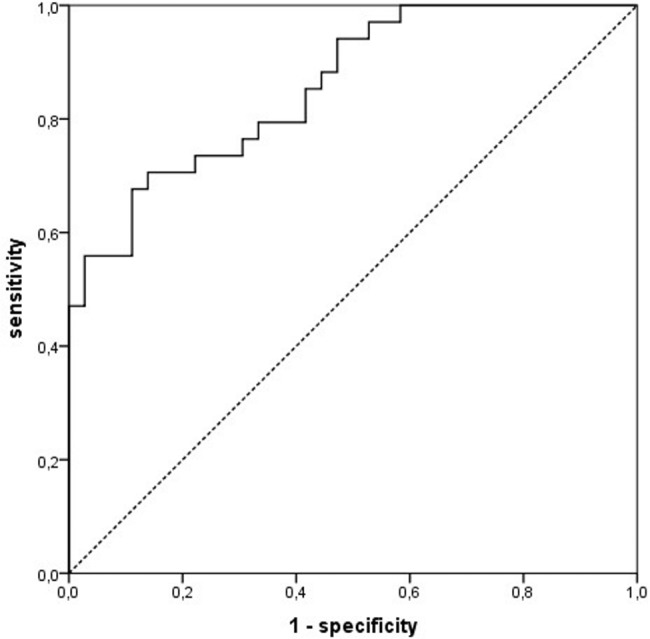
Receiver operating characteristic—curve for the prediction of nodular hyperplasia in individual parathyroid glands by the use of the prognostic model.The AUROC is 0.857 with a binominal exact 95% confidence interval: 0.773–0.941. The best Youden index determined a predicted probability of 52.9% as the cut-off value with best sensitivity and specificity for prediction of nodular hyperplasia in individual (specificity 86.1%, sensitivity 70.6%, overall correctness 78.3%). Good model fit was demonstrated by use of Pearson (0.75), Deviance (0.49), and Hosmer-Lemeshow tests (0.16).